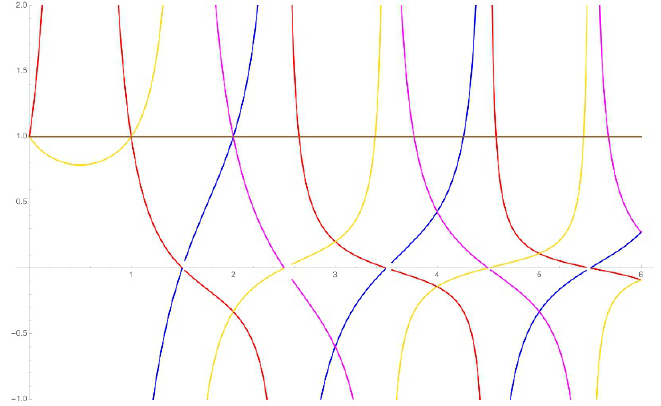
Figure 10 . The blue, red, magenta and yellow curves are the eigenvalues from diagonalizing the entries of the k s; 1 , k s; 2 , k a; 1 and k a; 2